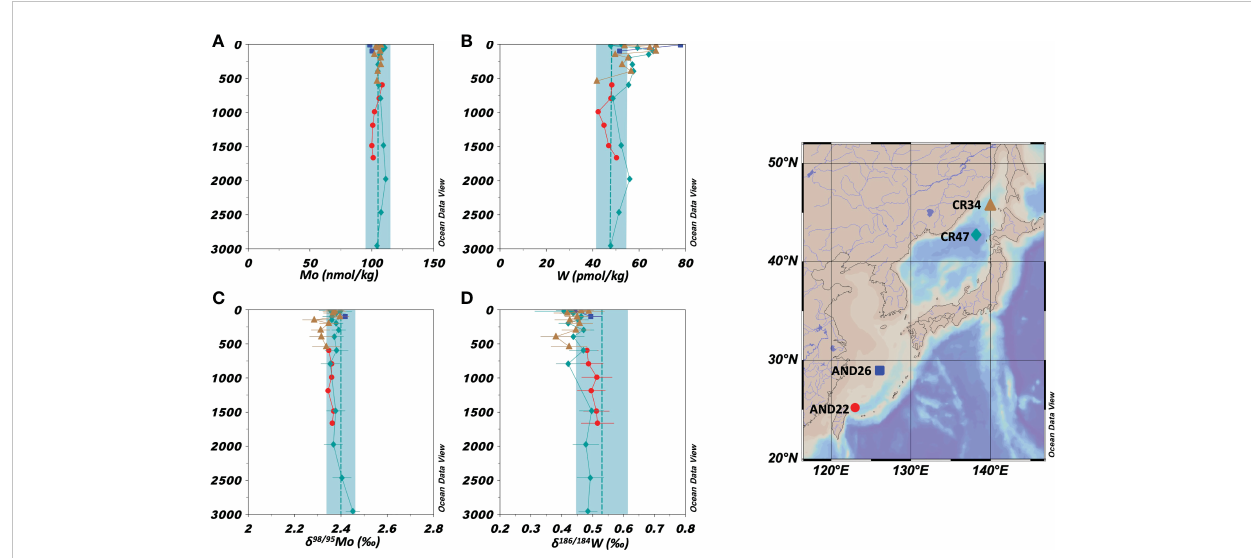
FIGURE 3 Vertical pro fi les of the concentrations and isotope ratios of Mo and W in the marginal seas (the East China Sea and the Sea of Japan). The data symbols are consistent with the sampling point symbols on the map. The error bar shows a standard deviation ( ± 1sd). (A) : Mo concentration. The blue columns show ranges of ave ± 2sd for all oceanic samples. (B) : W concentration. (C) : d 98/95 Mo. (D) : d 186/184 W.